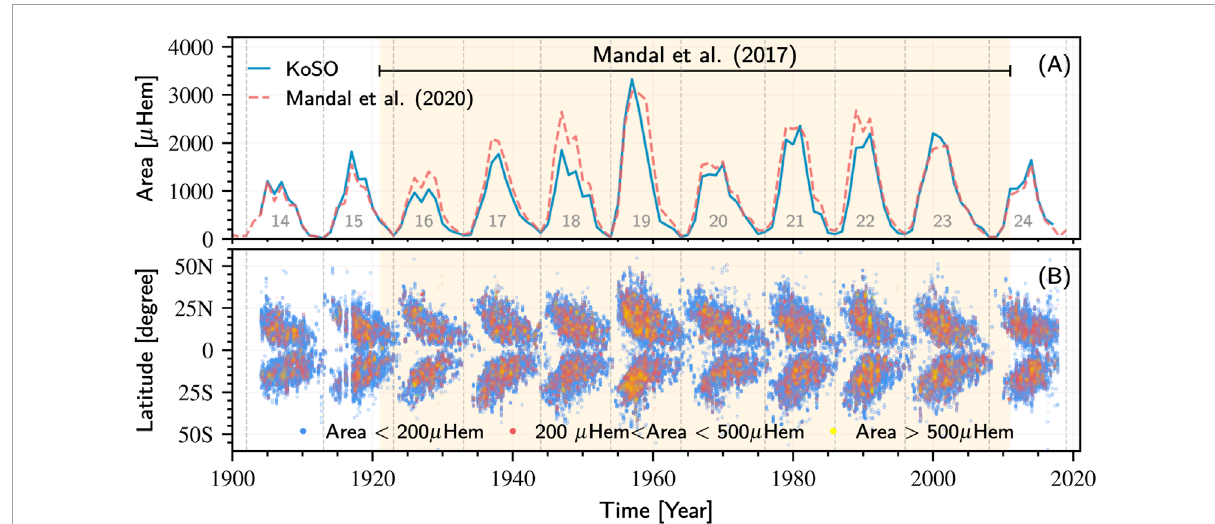
FIGURE 6 In panel (A) yearly averaged sunspot area obtained from KoSO white-light digitized data (solid blue) is plotted as a function of time along with the yearly averaged M2020 (dashed red). Panel (B) show the latitude time plot for the extended period obtained from KoSO sunspot data.